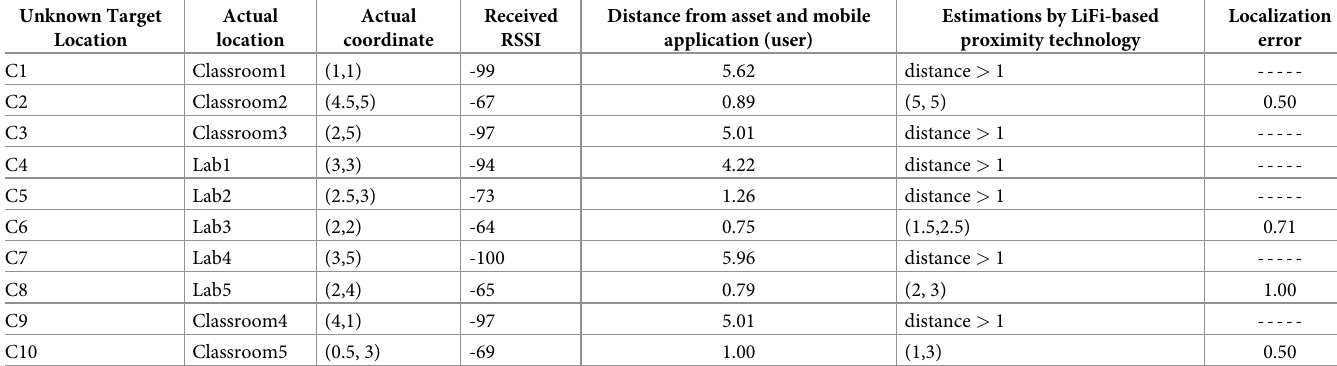
Table 4. The different between the actual locations and estimated locations.